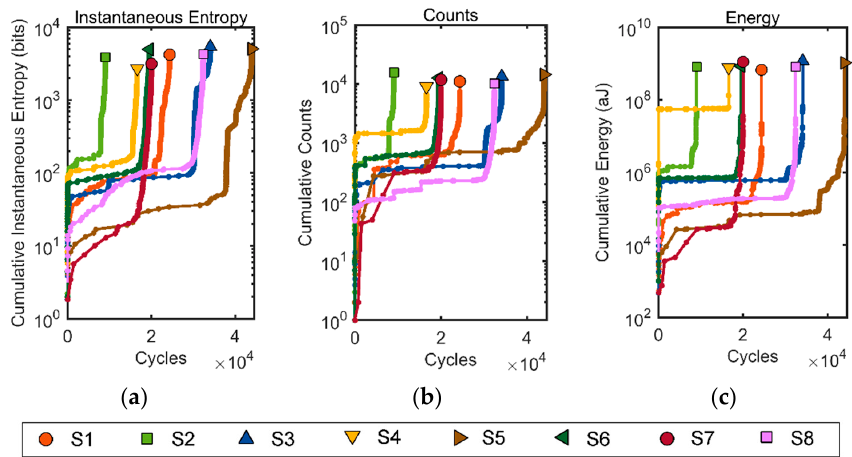
Figure 7. Cumulative trend for three parameters versus fatigue cycles for specimen 1 (S1) to specimen 8 (S8): ( a ) cumulative instantaneous entropy; ( b ) cumulative counts; and ( c ) cumulative energy.